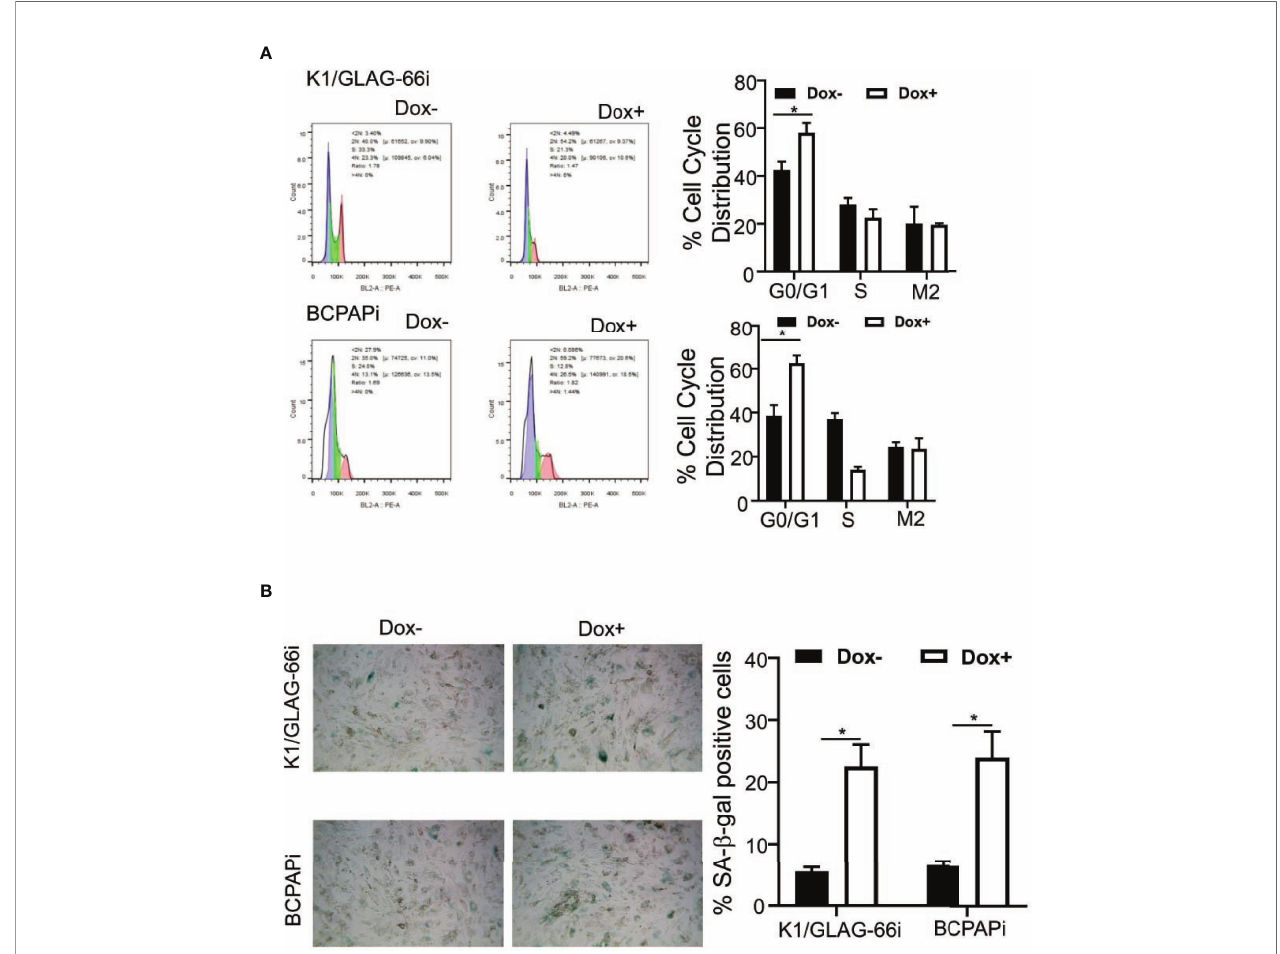
FIGURE 3 | Ectopic ZNF24 expression led to THCA cell aging. (A) ZNF24 induces G0/G1 cell cycle arrest in K1/GLAG-66i and BCPAPi cells. Cell proportions at G0/G1, S, G2/M phases. BCPAPi and K1/GLAG-66i cell lines were exposed to 3 days of 1 µg/ml DOX treatment or not, the distribution of cell cycle (left) and the related statistics (right) were analyzed by FACS analysis. (B) ZNF24 ectopic expression induced senescence of THCA cells. BCPAPi and K1/GLAG-66i cell lines were exposed to 48 h of 1 µg/ml DOX treatment or not, the activity of aging-related b -galactosidase (left) and the related statistics (right) were analyzed to determine the aging cells. Values are obtained from three independent assays, while unpaired t-test was used for analysis. Error bars=SD. *P <